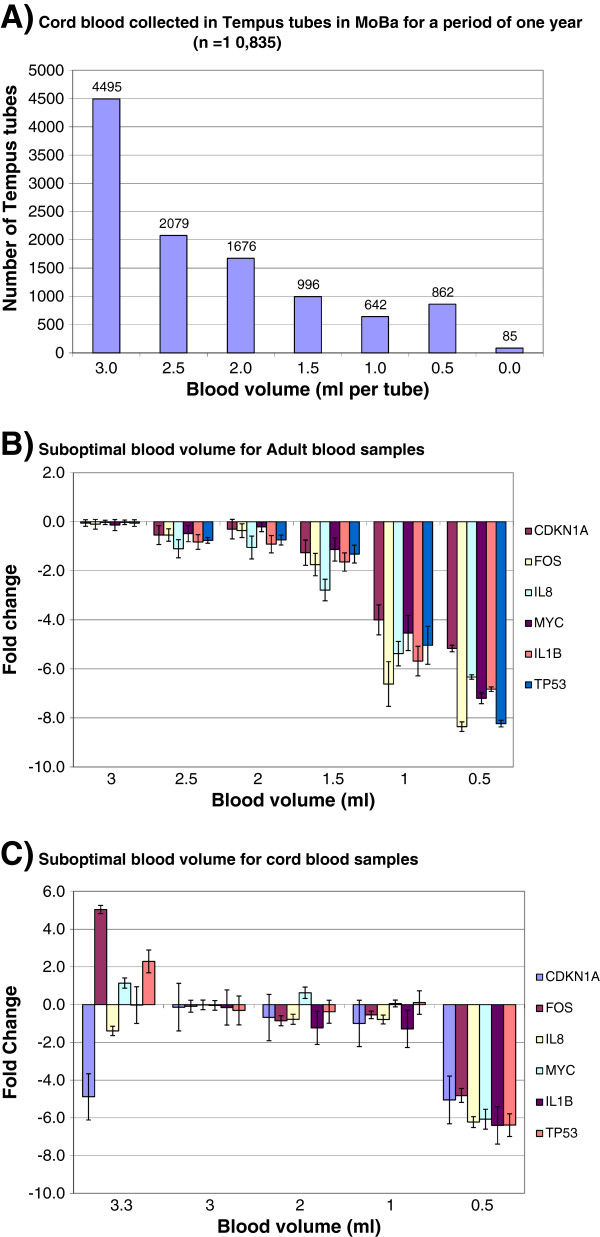
The effect of suboptimal blood volume collected in the Tempus tubes on RNA quality and transcript stability. A) Cord blood collected in Tempus tubes from maternity units in a period of one year (n = 10 853). B) The effects of suboptimal volume of adult blood collected in the Tempus tubes on relative transcript level for six genes. Adult blood from one healthy donor was collected in Tempus tubes (n = 18). The following blood volumes (3.0, 2.5, 2.0, 1.5, 1.0 and 0.5 ml) were collected in the Tempus tubes (n = 3; three parallels tubes for each blood volume). C) The effects of suboptimal volume of cord blood collected in the Tempus tubes on relative transcript level for six genes. Cord blood from one donor was collected in Tempus tubes (n = 10). The following blood volumes (3.3, 3.0, 2.0, 1.0, and 0.5 ml) were collected in the Tempus tubes (n = 2; two parallels tubes for each blood volume). Samples with 3 ml blood per tube were used as reference samples; hence all other samples were compared against the reference samples. Each bar represents the average log2-transformed fold change values and the error bar indicates = SE. Since some of the samples had low RNA quality, selecting stably expressed reference genes for normalization was a challenge. We therefore used the average Cq value for each gene to normalize the samples: ΔCq (sample) = Cq (gene) – Cq (average); these values where converted into linear scale, 2-ΔCq. Fold changes were calculated by dividing ΔCq value of the sample by the ΔCq value of the reference sample.